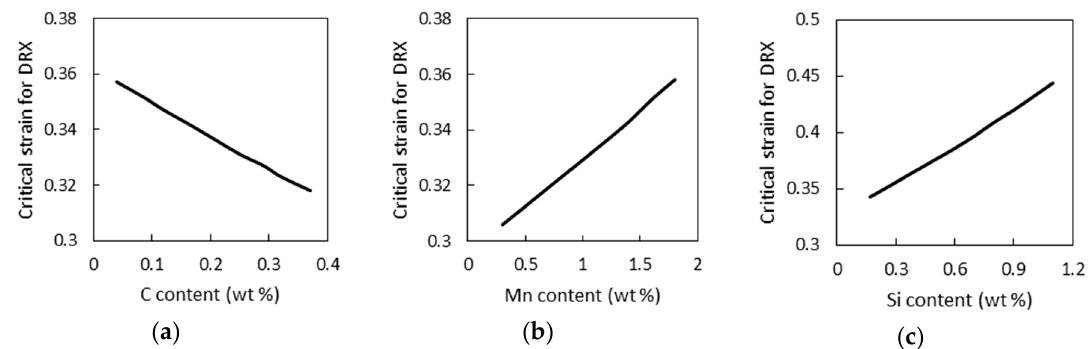
Figure 6. The influence of the content of ( a ) carbon, ( b ) manganese, and ( c ) silicon in low-alloyed steels on the critical strain for dynamic recrystallization.